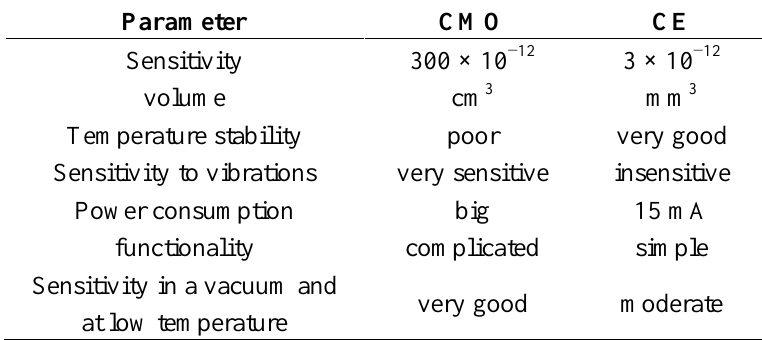
Table 1. Comparison of important characteristics of CMO and CE systems (CMO stands for Chemo Mechanical sensing with Optical detection and CE stands for comb Capacitive sensing with Electronic